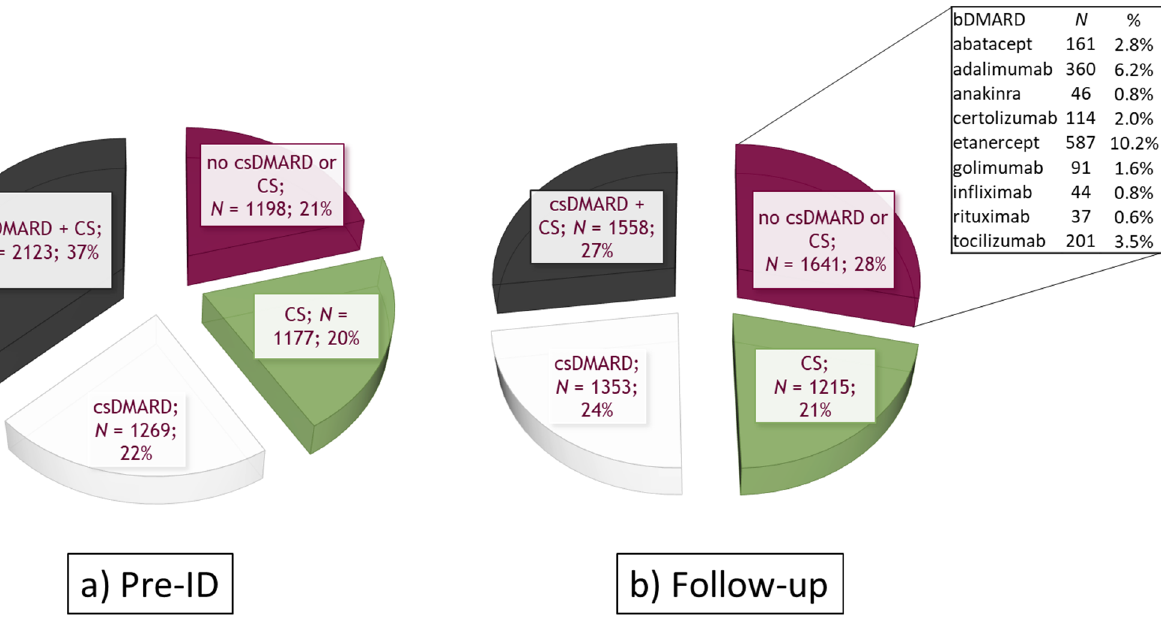
Figure 3. Treatment patterns in the bDMARD cohort ( N = 5767) ( a ) in the 12 months before ID (pre-ID); ( b ) during follow-up. Abbreviations: csDMARDs, conventional synthetic disease-modifying antirheumatic drugs; CS, corticosteroids.